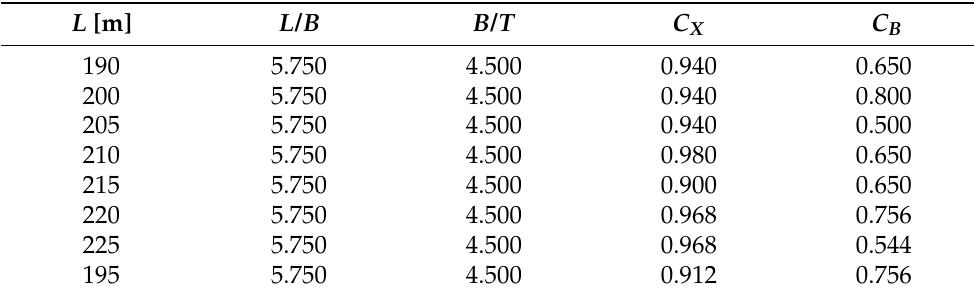
Table 4. Primary geometrical characteristics of parent